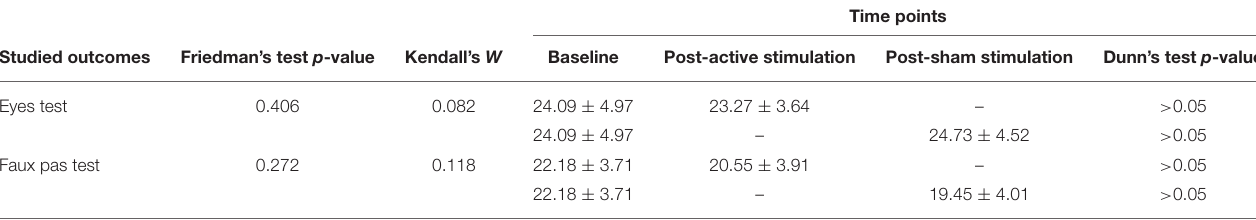
TABLE 2 | The effects of sham and active stimulation on Eyes Test and Faux Pas Test